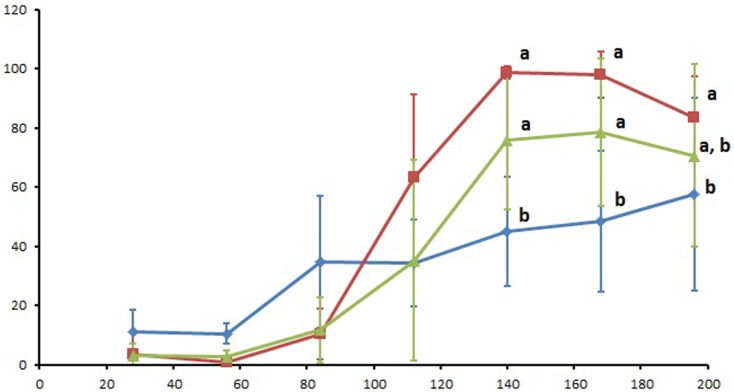
Serum SvSXP ELISA values presented as a percentage of a positive control over the course of the 196 study days. Blue diamonds: group 1 (treated with ivermectin on Day 56), red squares: group 2 (treated with ivermectin on Day 112), and green triangles: group 3 (no treatment control). Different letters designate statistically significant differences (p < 0.05) between groups at the given time points. Error bars represent 95% confidence intervals.